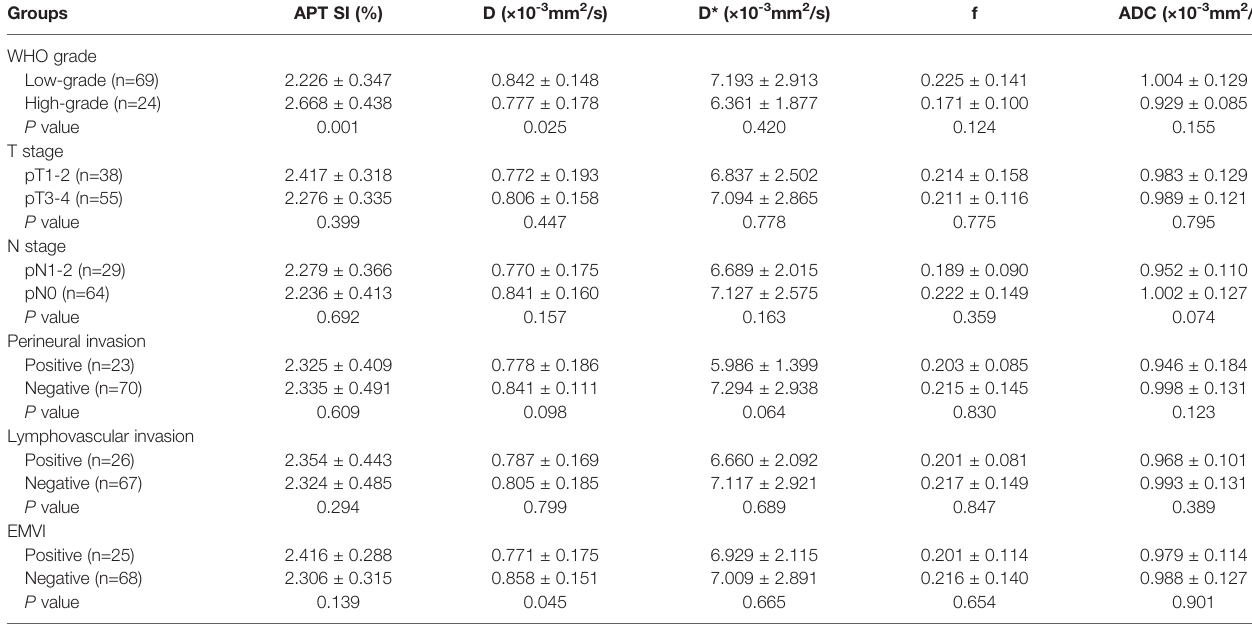
TABLE 4 | The comparison of APT SI, D, D*, f and ADC values in different groups of AC. Groups WHO grade Low-grade